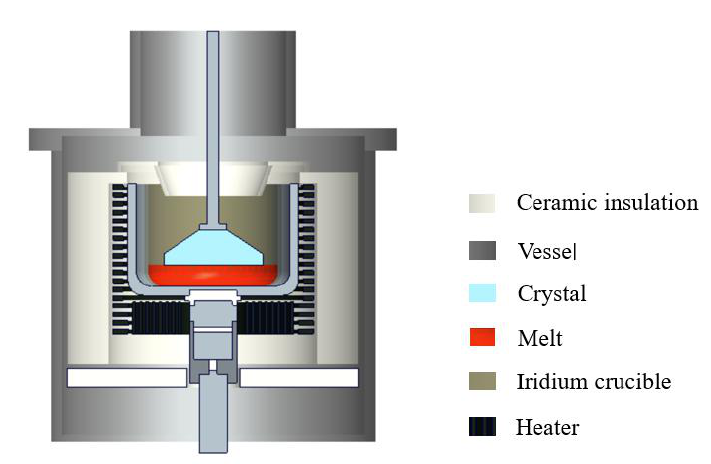
Figure 1. Scheme of the crystal growth